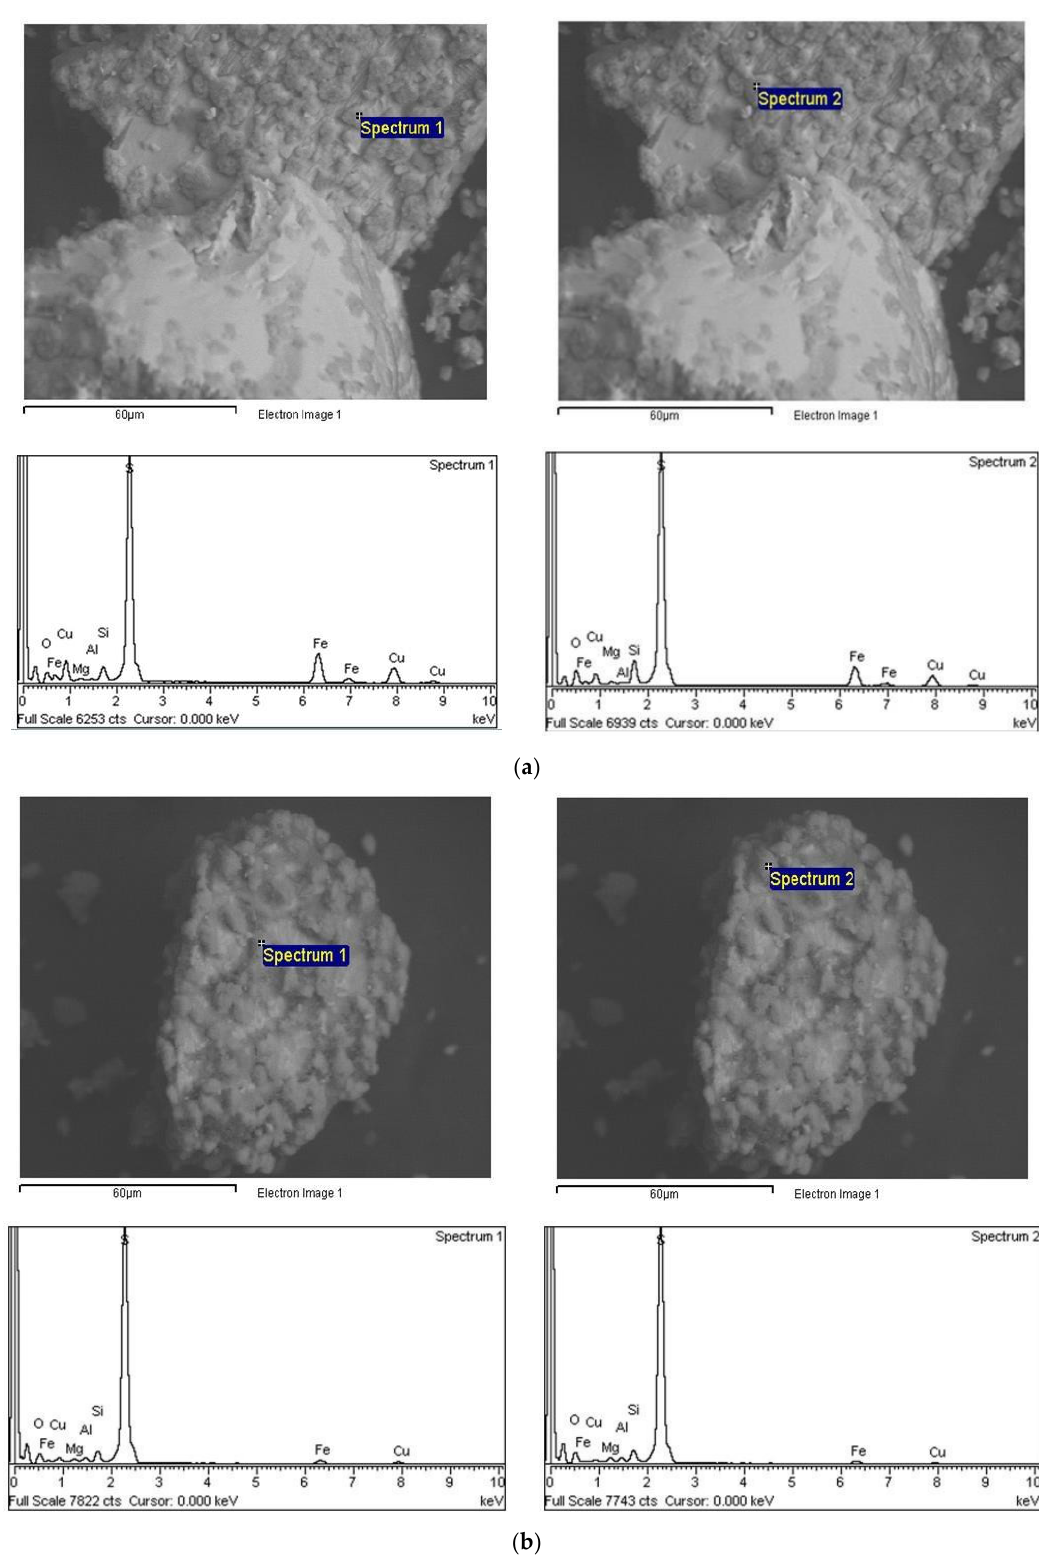
Figure 7. SEM–EDS analysis of solid residues from leaching at pH 1 and 2.5 g L −1 Cu 2+ : ( a ) 0 g L −1 Cl − , and ( b ) 5 g L −1 Cl − .